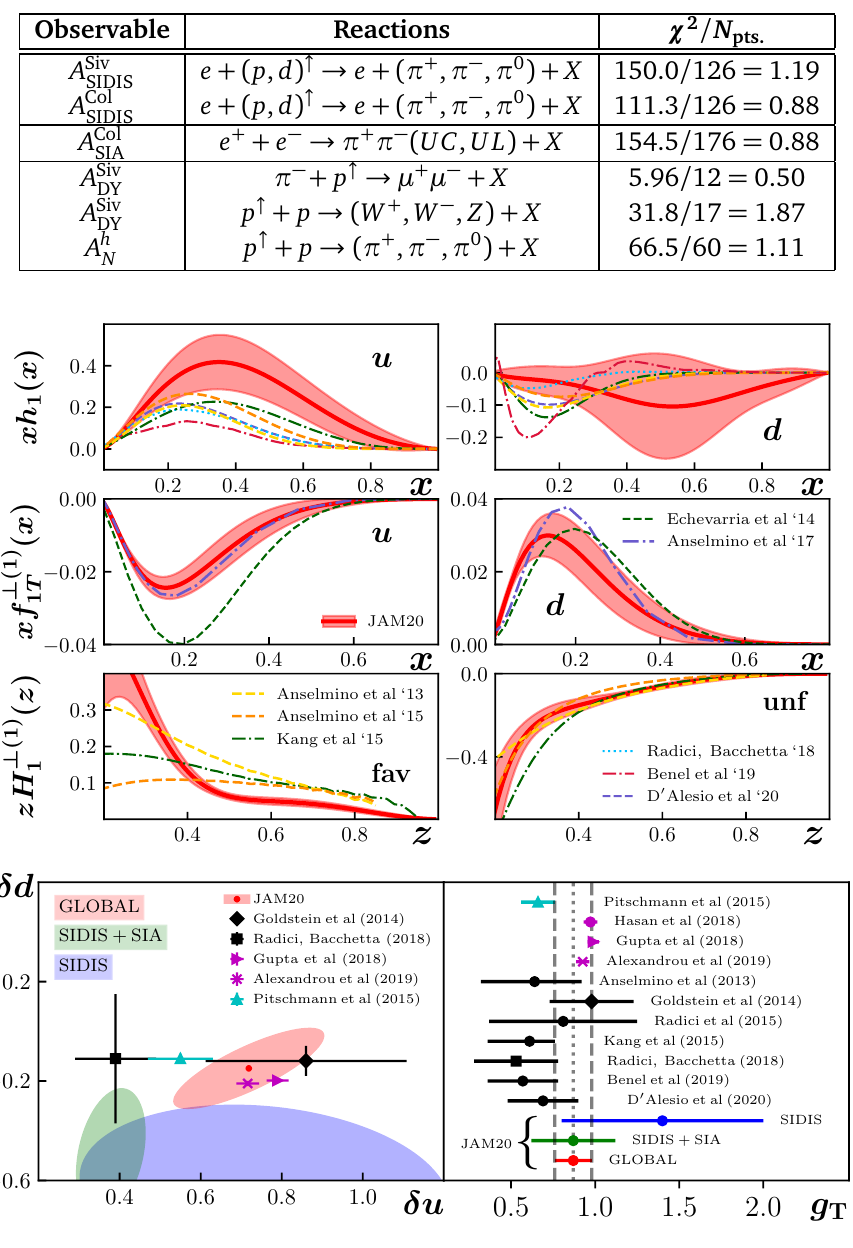
( x ) , f ⊥ ( 1 ) ( x ) , and H ⊥ ( 1 ) ( z ) at Q 2 = 4 GeV 2 Figure 1: (Top) The extracted functions h 1 1 T 1 from our (JAM20) global analysis (red solid curves with 1- σ CL error bands). The functions from other groups [ 13–20 ] are also shown. (Bottom) The tensor charges δ u , δ d , and g . Our (JAM20) results at Q 2 = 4 GeV 2 along with others from T phenomenology (black) [ 13, 15, 18–22 ] , lattice QCD (purple) [ 23–25 ] , and Dyson- Schwinger (cyan) [ 26 ]